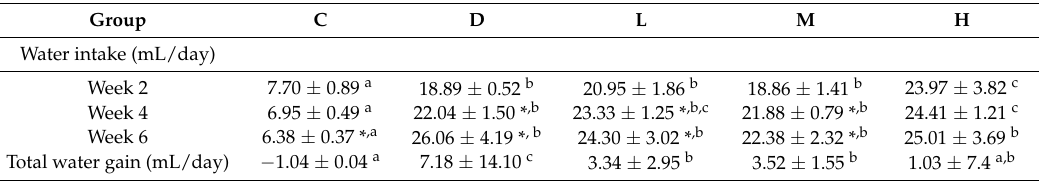
Table 2. Water intake during melatonin intervention at 2, 4, and 6